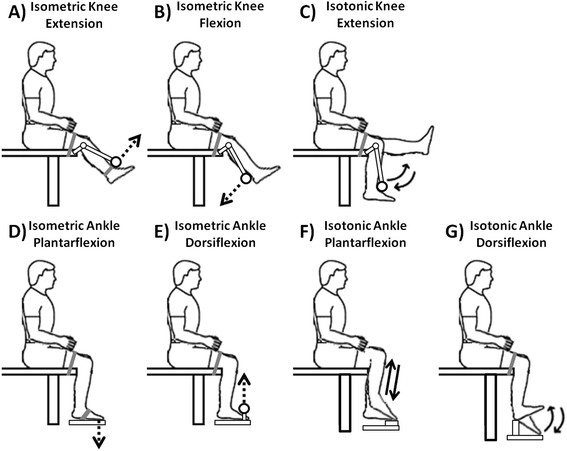
A sketch of the experimental setup for A) isometric knee extension, B) isometric knee flexion, C) isotonic knee extension, D) isometric ankle plantar flexion, E) isometric ankle dorsiflexion, F) isotonic ankle plantar flexion, and G) isotonic ankle dorsiflexion. For isometric exercises the direction of the applied force is indicated by a dashed arrow. For isotonic exercises the direction of movement is indicated by solid arrows.